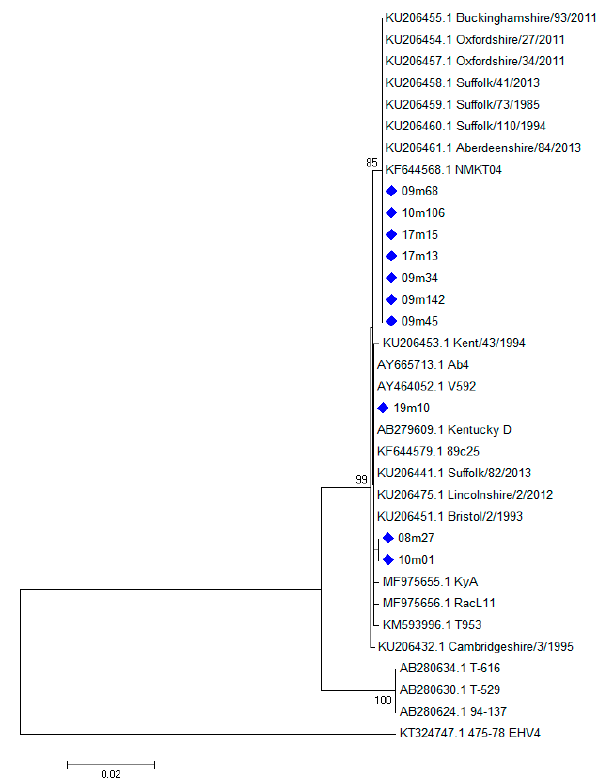
Figure 1. Phylogenetic tree showing the evolutionary history of the ORF33 sequences from nt 1525 to nt 2409 (Neighbor-Joining method with bootstrap test with 1000 replicates). The evolutionary distances were computed using the Kimura 2-parameter method and are in the units of the number of base substitutions per site. The rate variation among sites was modeled with a gamma distribution (shape parameter = 5). Sequences obtained in this study are marked with a diamond ( (cid:7) ). Table 3. Nucleotide variations in ORF33 gene of samples and of the reference isolate Ab4.